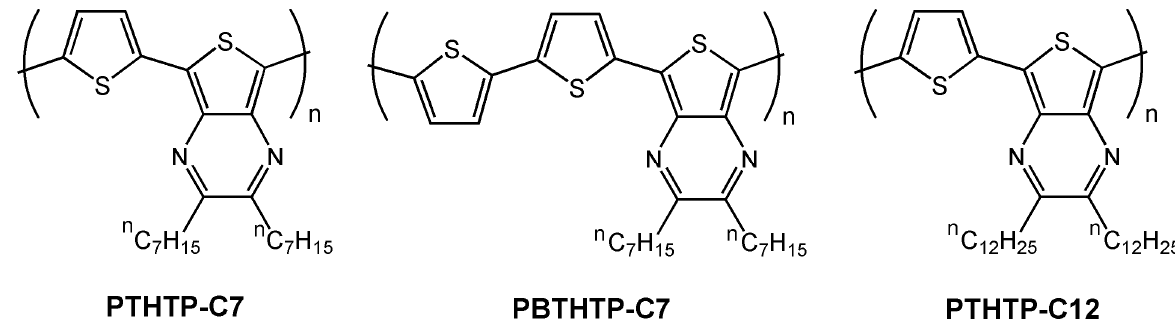
Figure 12. Chemical structures of the semiconducting copolymers PTHTP-C7 , PBTHTP- C7 , and PTHTP-C12